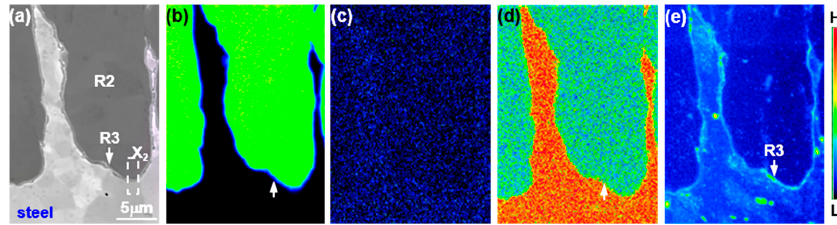
Figure 8. EPMA analysis results of the reaction layers near the steel–R2 interface that was hot-dipped at 690 °C for 120 s: ( a ) BSE Image; ( b ) Al; ( c ) Ni; ( d ) Fe; ( e ) C.